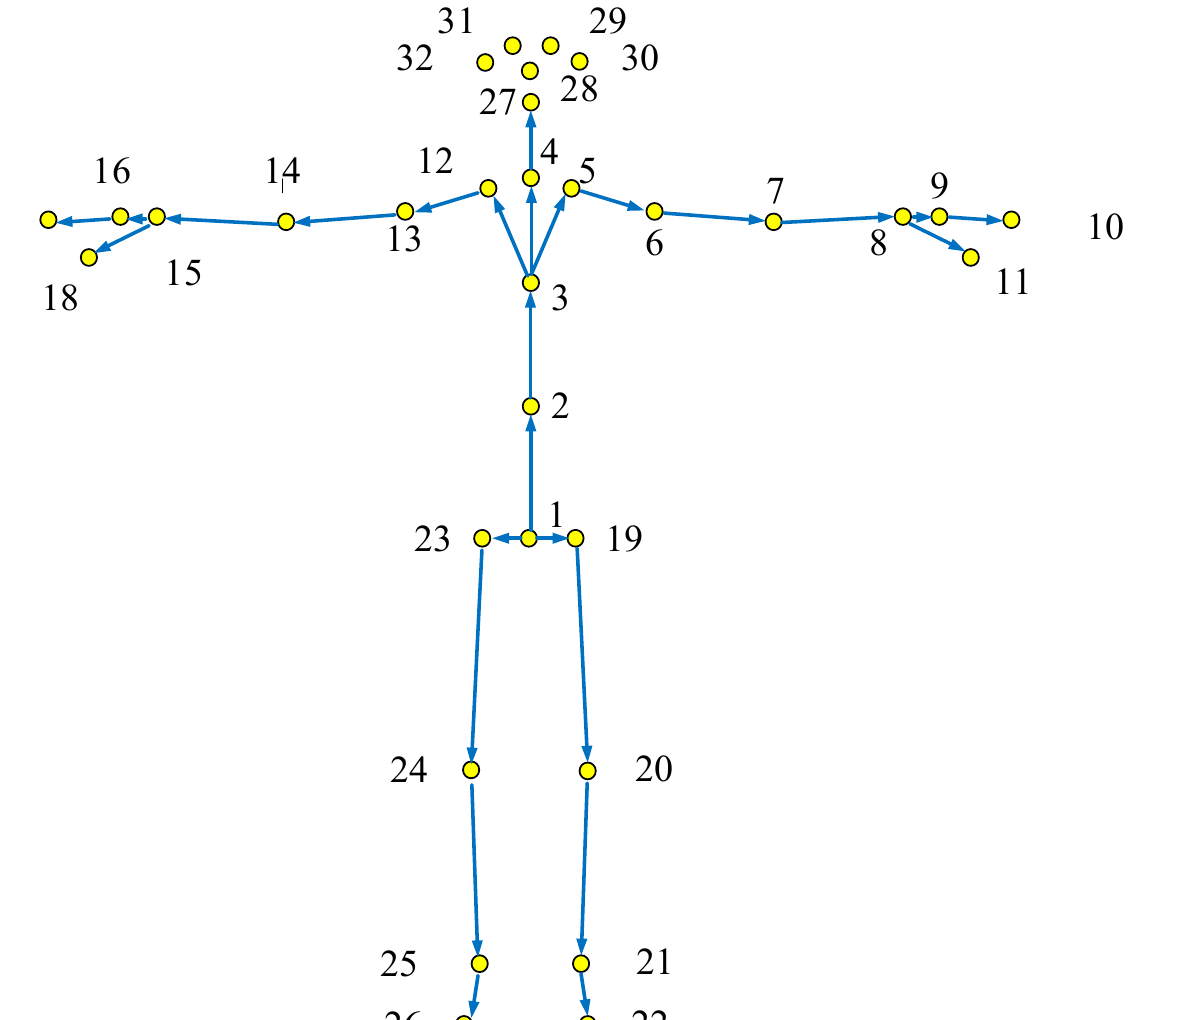
Figure 1. Distribution of 32 joint points.